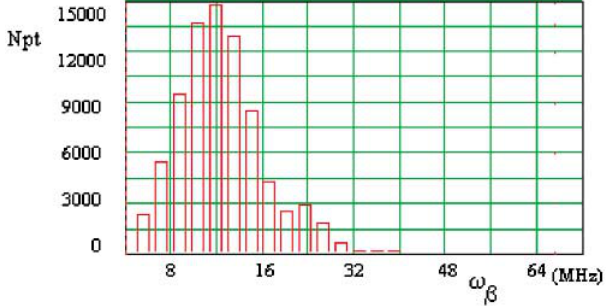
FIG. 11. (Color) Beam betatron frequency distribution with initial Gaussian particle distribution for s (cid:5) s 0 (cid:2) 0.29 (cid:1) I (cid:2) 200 mA (cid:2) . The odd mode half frequency, v o , is 32 MHz and the even mode half frequency, v e , is 42